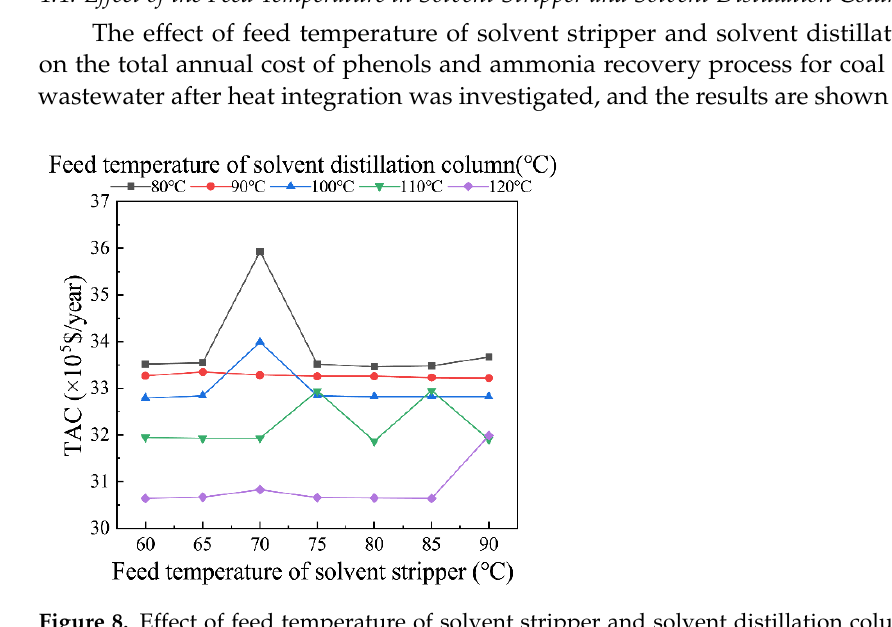
Table 6. Optimal parameters at the lowest total annual cost. Name